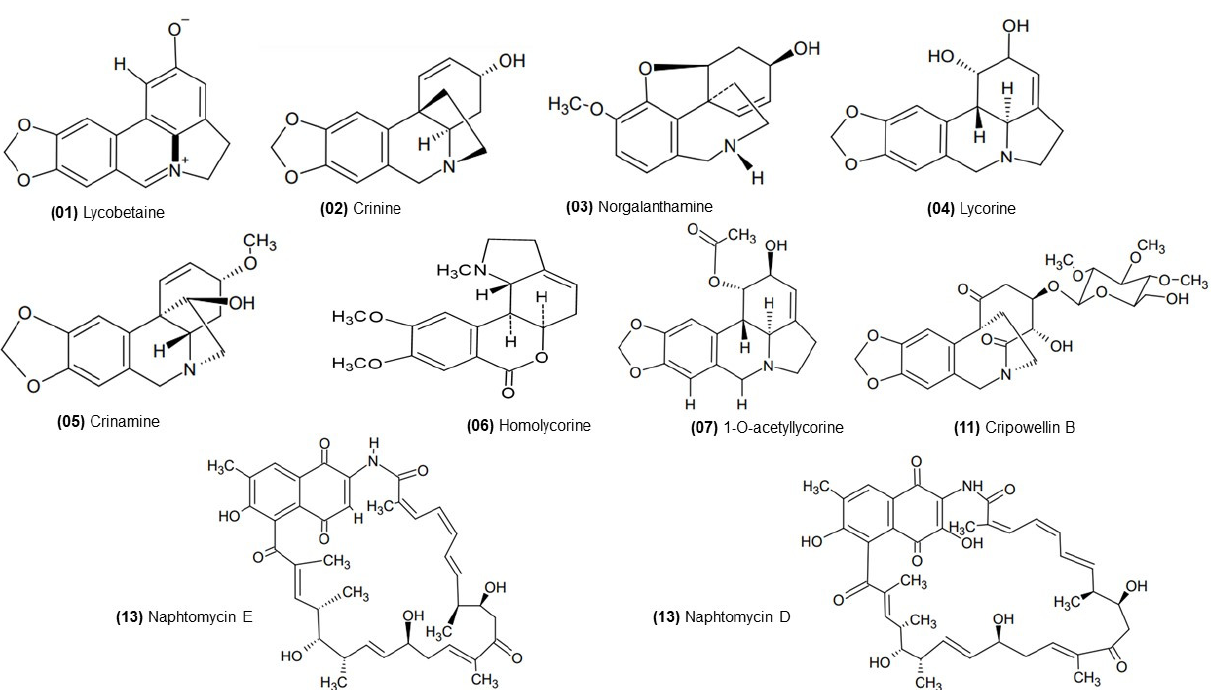
Figure 3. Compounds identified in the bulb and leaf extracts of Crinum americanum L.